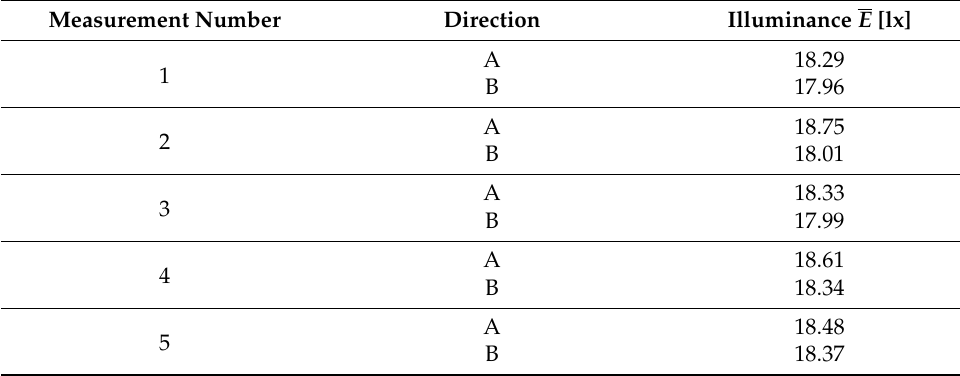
Table 2. Example of the results for measurement field No.